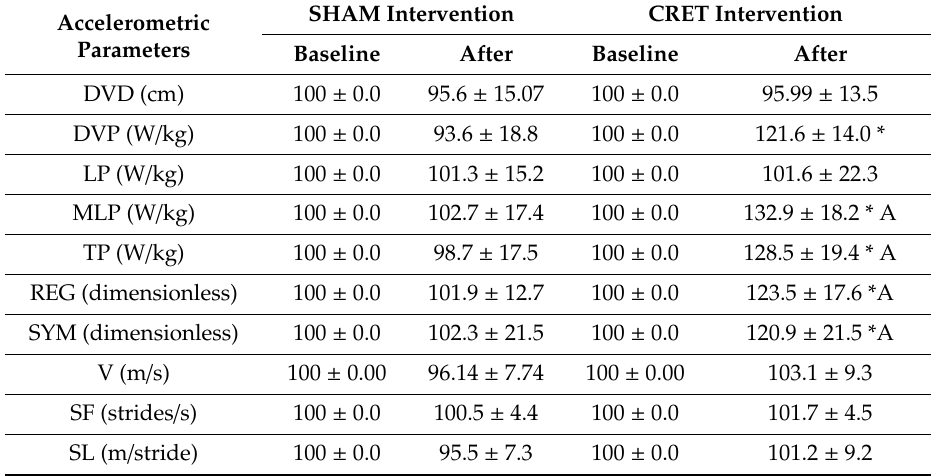
Table 7. Mean values of the accelerometric parameters measured at trot and with the accelerometer fixed in the sacrum midline, before and after the intervention (SHAM group and capacitive resistive electric transfer therapy group (CRET)). Data are expressed as the mean percentage ± SD, relative to baseline